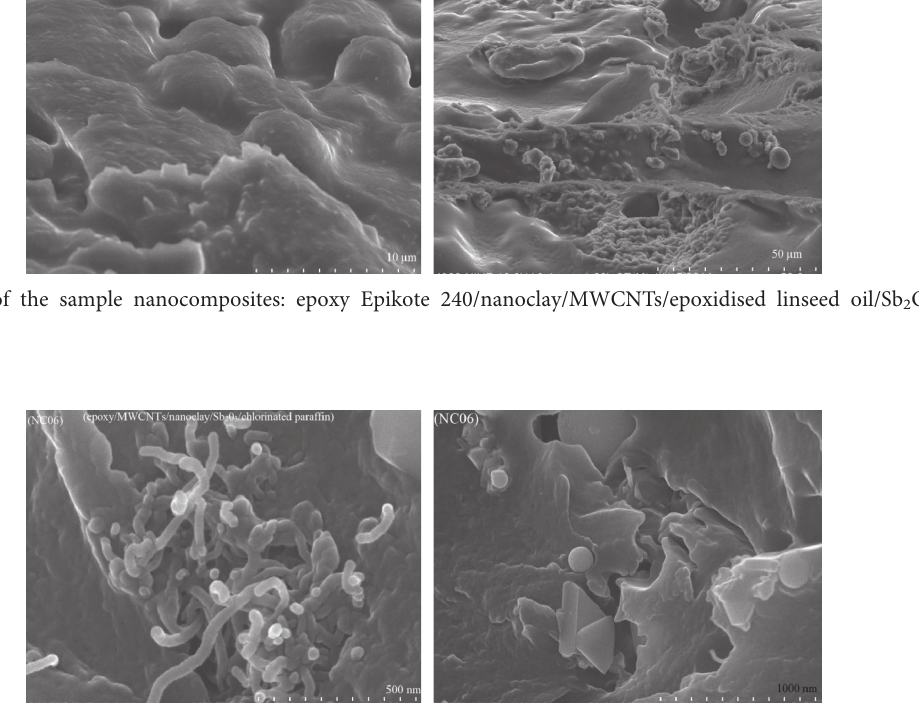
2 O 3 /chlorinated paraffin.